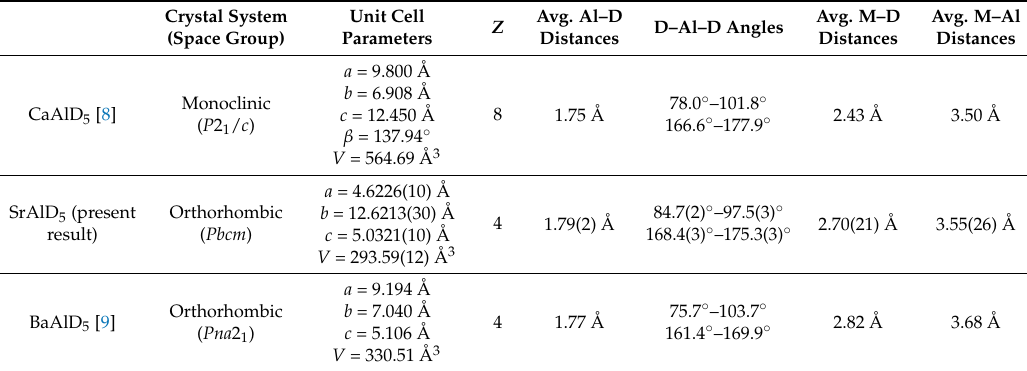
Table 3. Crystal structure data for MAlD 5 and selected inter-atomic distances and angles (Estimated standard deviations for SrAlD 5 are in